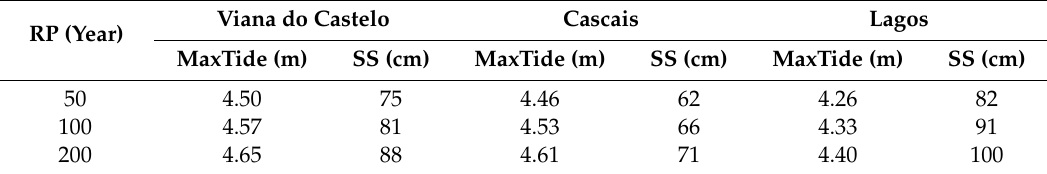
Table 1. Maximum tide height, relative to the respective TG chart datum, and storm surge (SS) for the 50-, 100-, and 200-year return periods, for the previous three TGs.